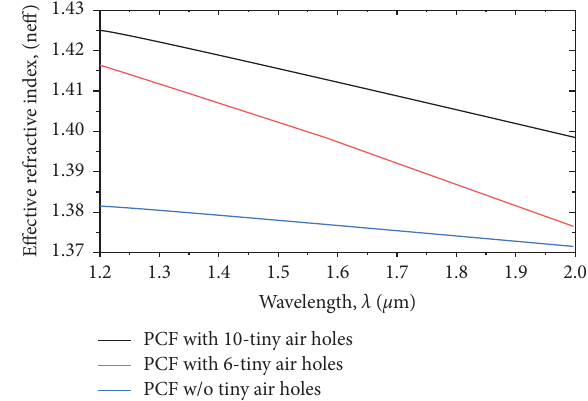
Figure 6: Efective refractive index as a function of operating wavelength for diferent PCFs at a constant air hole size of 1.5 μ m, a pitch size of Λ � 2.2, and an air flling ratio of d